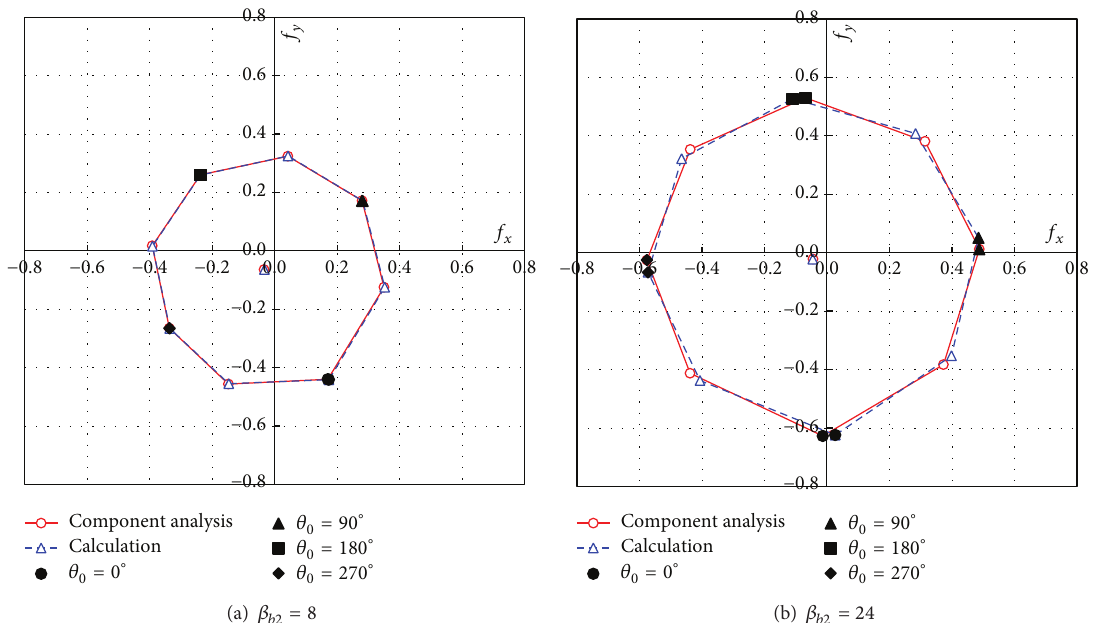
Figure 9: Lissajous figures of hydraulic part radial thrust coefficient ( 𝜑 = 0.030